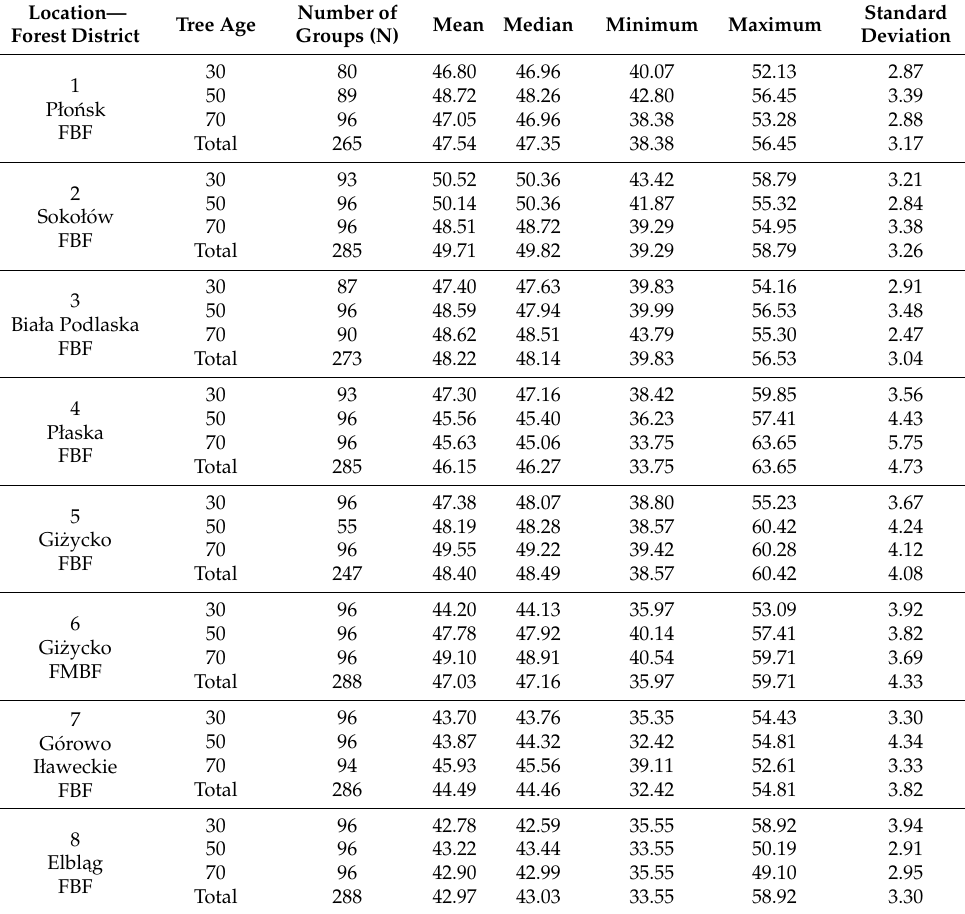
Table A2. Characteristics of Brinell hardness of silver birch wood on a radial section